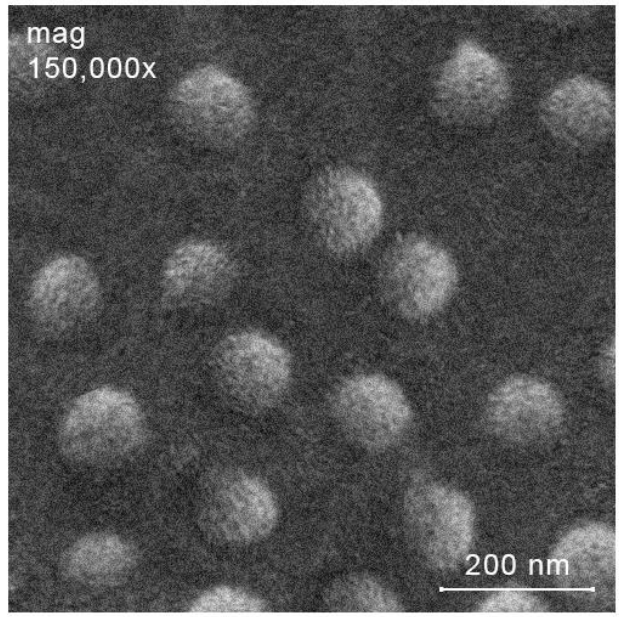
Figure 4. SEM image of the nanoparticles prepared by ionic gelation method ( NPs-C-SP-CS-III-M ).